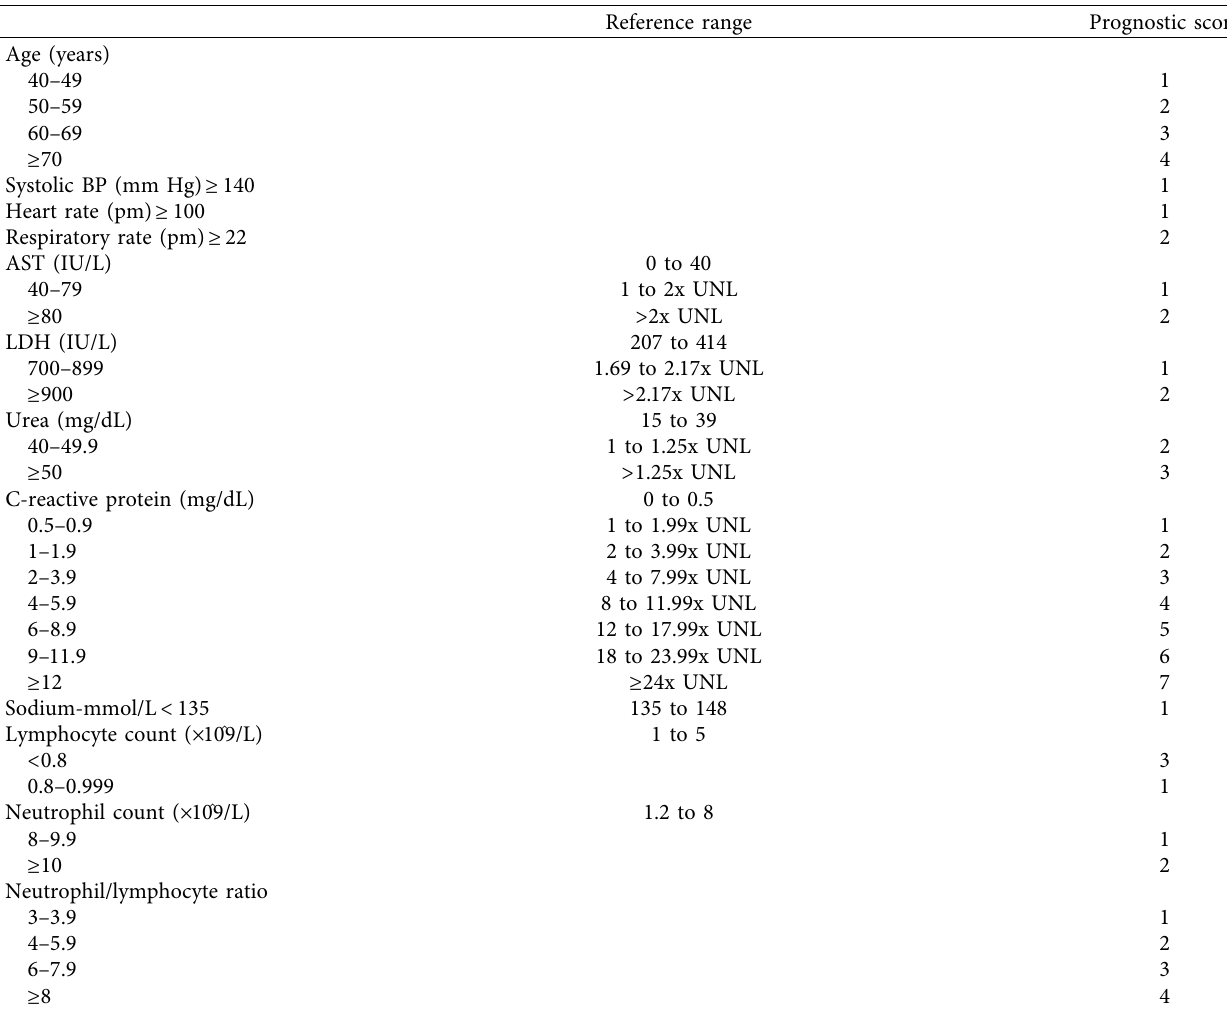
Table 2: The RCOS prognostic index.